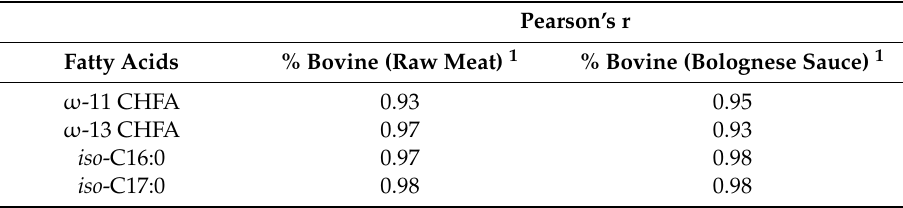
Table 2. Pearson’s correlation coe ffi cient (r) between cyclohexyl fatty acids (CHFAs) or iso -branched fatty acids concentrations and the percentage of bovine meat both in raw and cooked minced